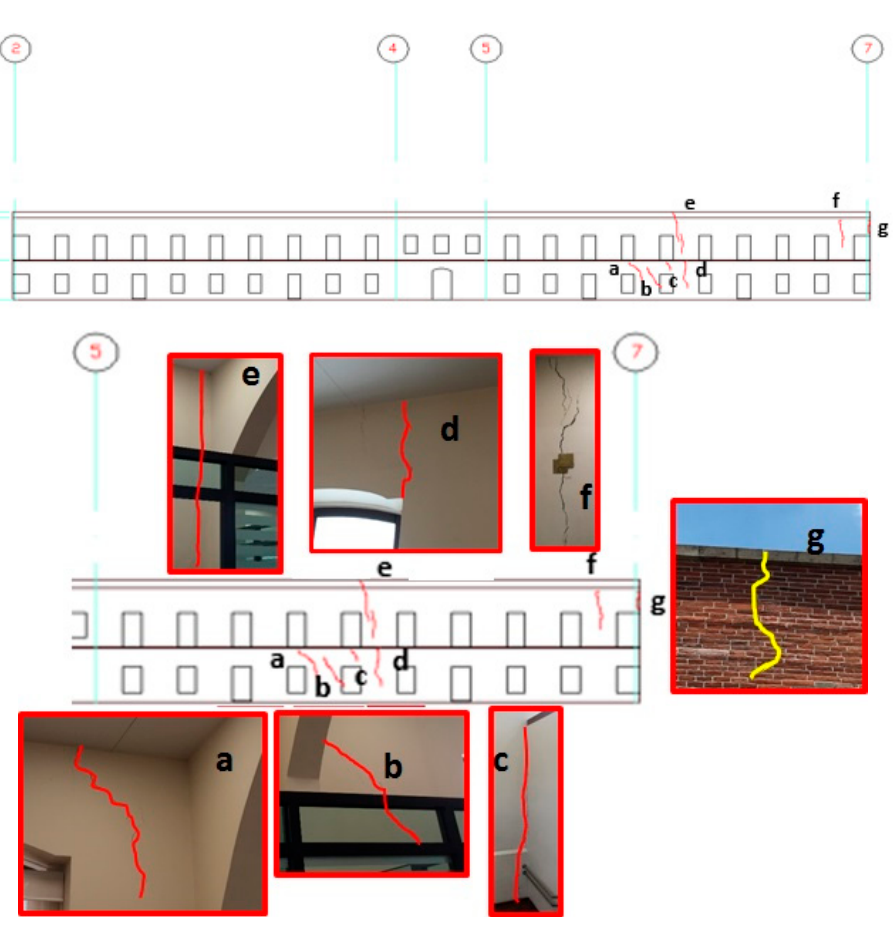
Figure 5. Layout of the damage survey on axis C [9].